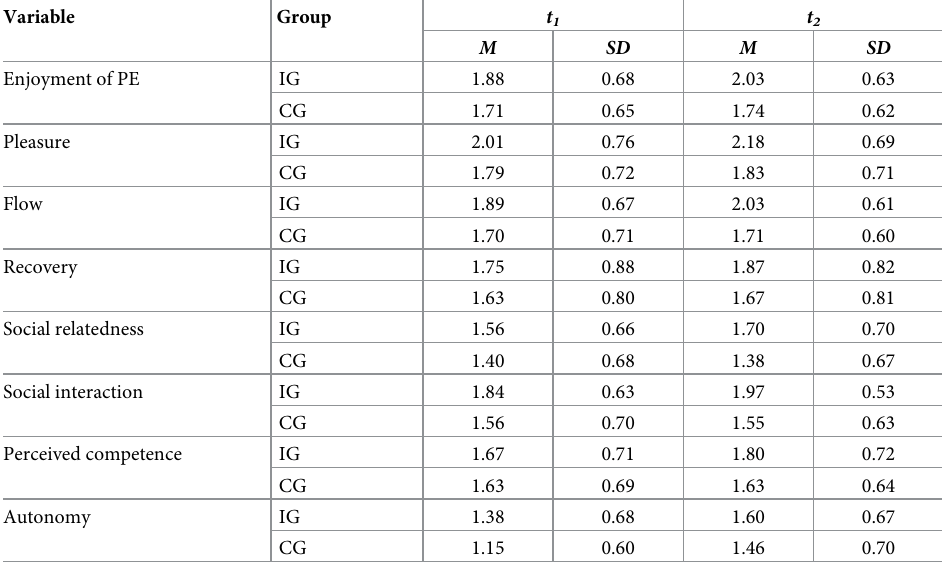
Table 2. Scale means, standard deviation for intervention and control group for both times of